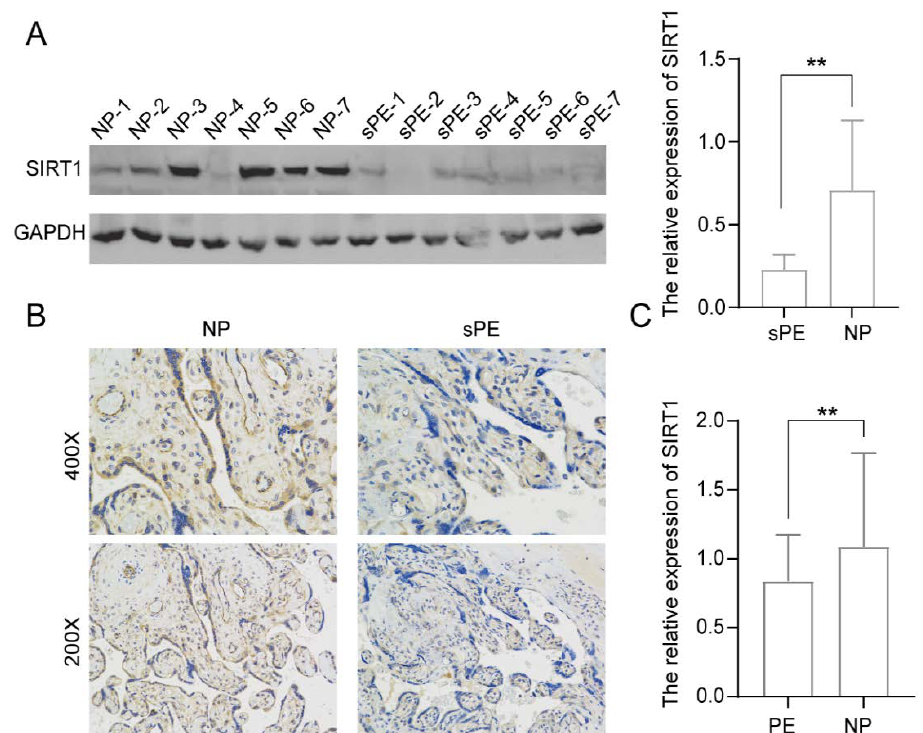
Figure 1. SIRT1 was significantly lower in the placentas and serum samples of pre-eclampsia patients. ( A ) Western blot analysis of SIRT1 protein levels in placental tissues from normal pregnancy women (NP, n = 7) and women with pre-eclampsia with severe features (sPE, n = 7). ( B ) Immunohisto- chemistry for SIRT1 in placental tissues from NP women ( n = 7) and sPE women ( n = 7). ( C ) ELISA analysis of the SIRT1 concentration in the serum of PE women ( n = 76) and gestational age-matched NP women ( n = 95). Error bars, mean ± SD. The data were analyzed by an unpaired Student’s test. ** p < 0.01.